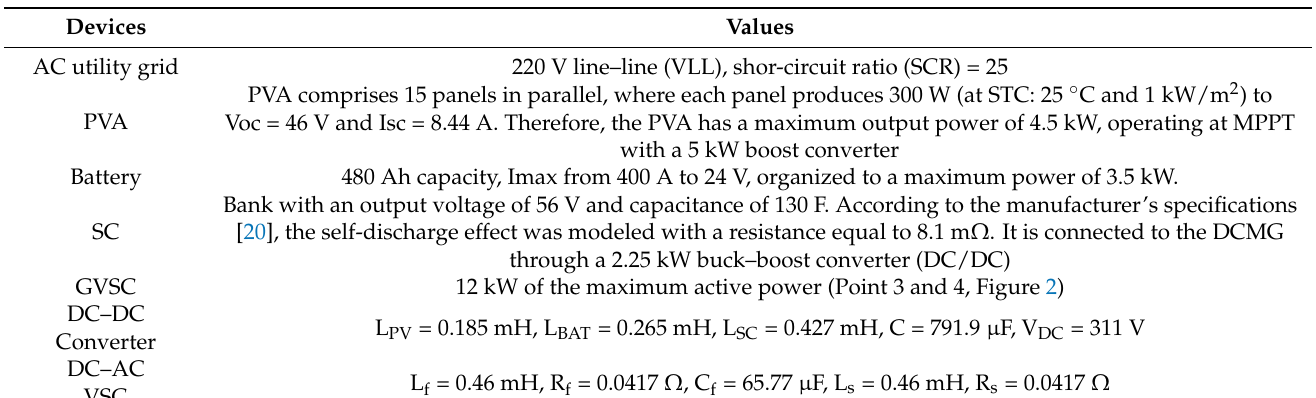
Table 1. Systems parameters.